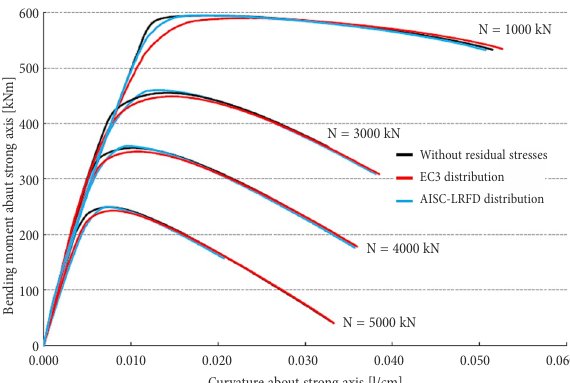
Fig. 12. Moment-curvature analysis for different values of compressive axial loads with and without residual stress effects: strong axis bending